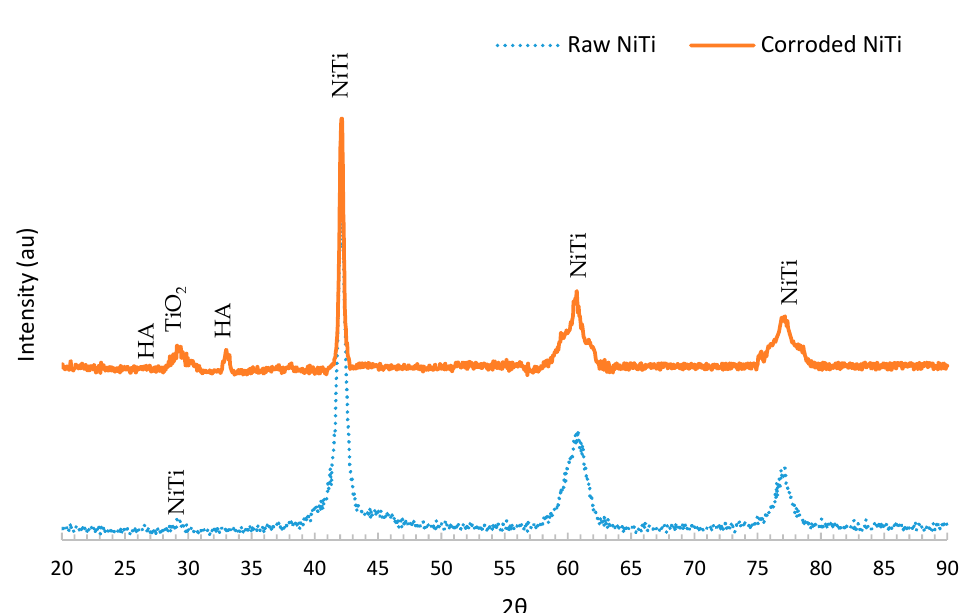
Figure 8. XRD graphs of additively manufactured (raw) and corroded NiTi parts.